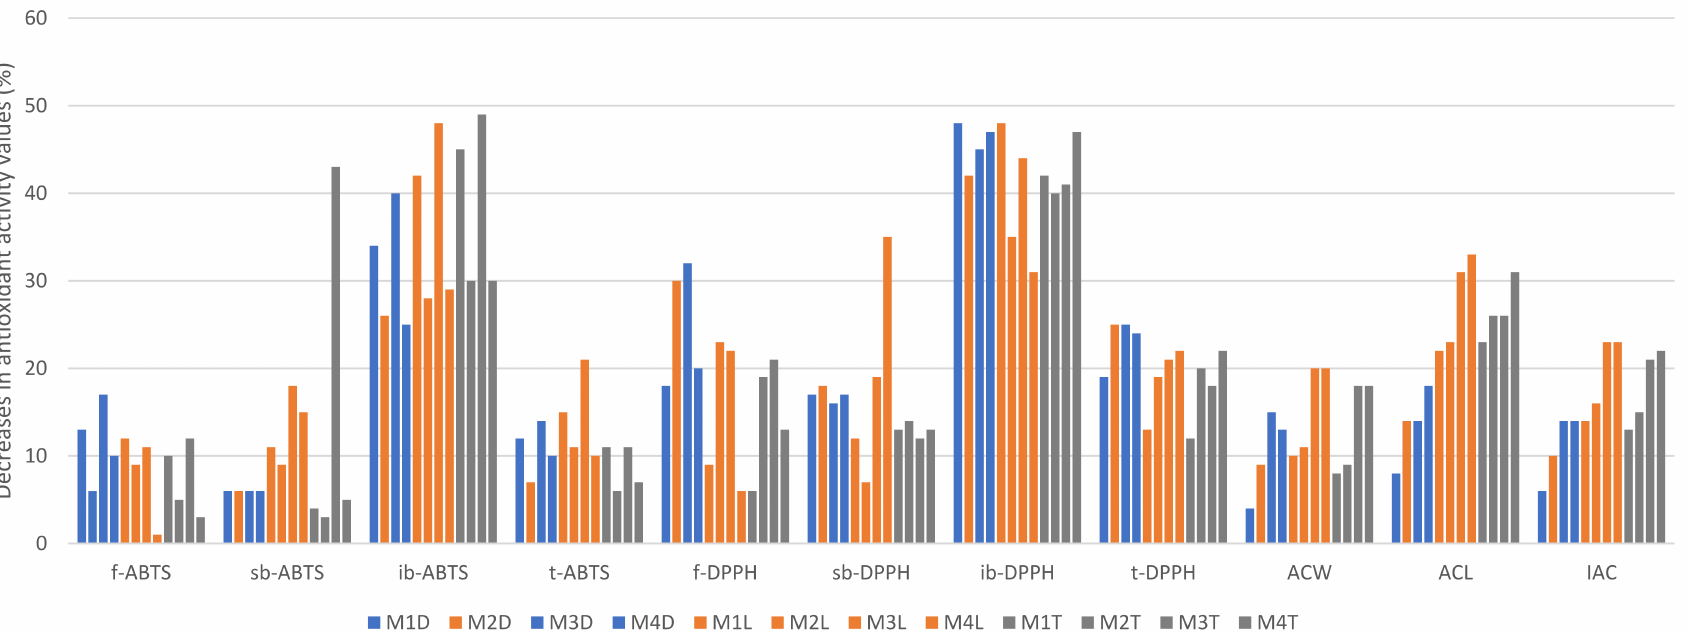
Figure 6. Percentage decreases in the antioxidant activity values for the individual phenolic fraction and the water- and lipid-soluble antioxidants of the M1–M4 nutraceutical mixtures under the defined storage conditions. Prefixes: f (free phenolic fraction), sb (soluble bound phenolic fraction), ib (insoluble bound phenolic fraction), t (total content), ABTS or DPPH (antioxidant activity measured by quenching ABTS or DPPH radicals), ACW (water soluble antioxidants), ACL (lipid- soluble antioxidants), IAC (integral antioxidant capacity), D (storage without sunlight, blue color), L (storage in the presence of sunlight, orange color), T (storage in thermostatic device, grey